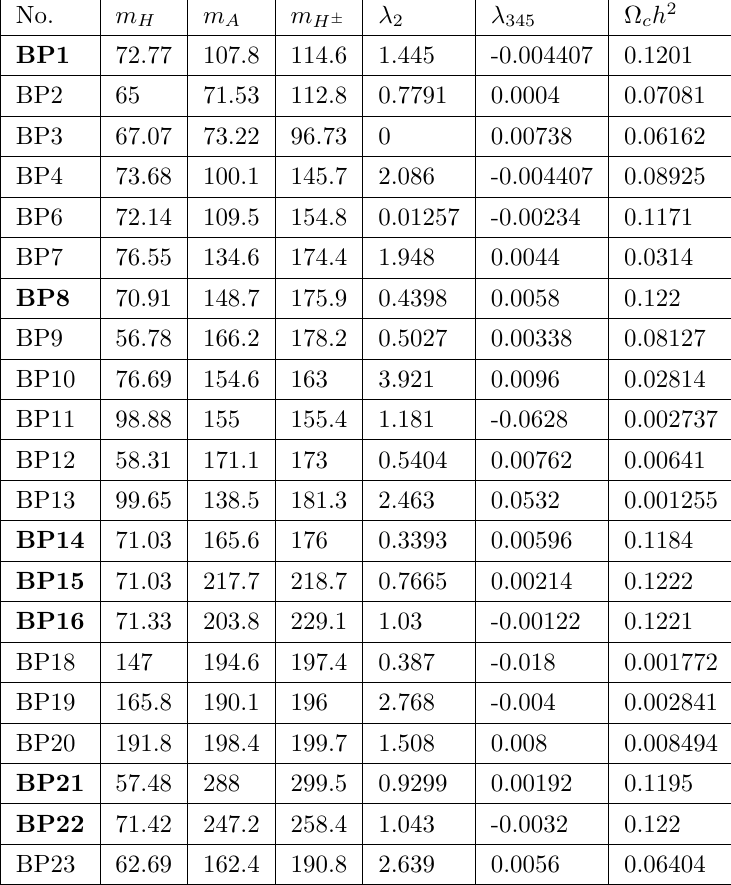
Table 1 . Low mass IDM benchmark points considered in the presented study, taken from [4]. In all benchmarks m h = 125 : 1 GeV. Bold font denotes BP for which H completely saturates DM relic density. Note that BP5 and BP17 were excluded by the updated Xenon1T limits [56]. The values of the (cid:21) 345 parameter for scenarios BP8 and BP22 were slightly modi(cid:12)ed with respect to [4], to be consistent with the most recent results on the relic density